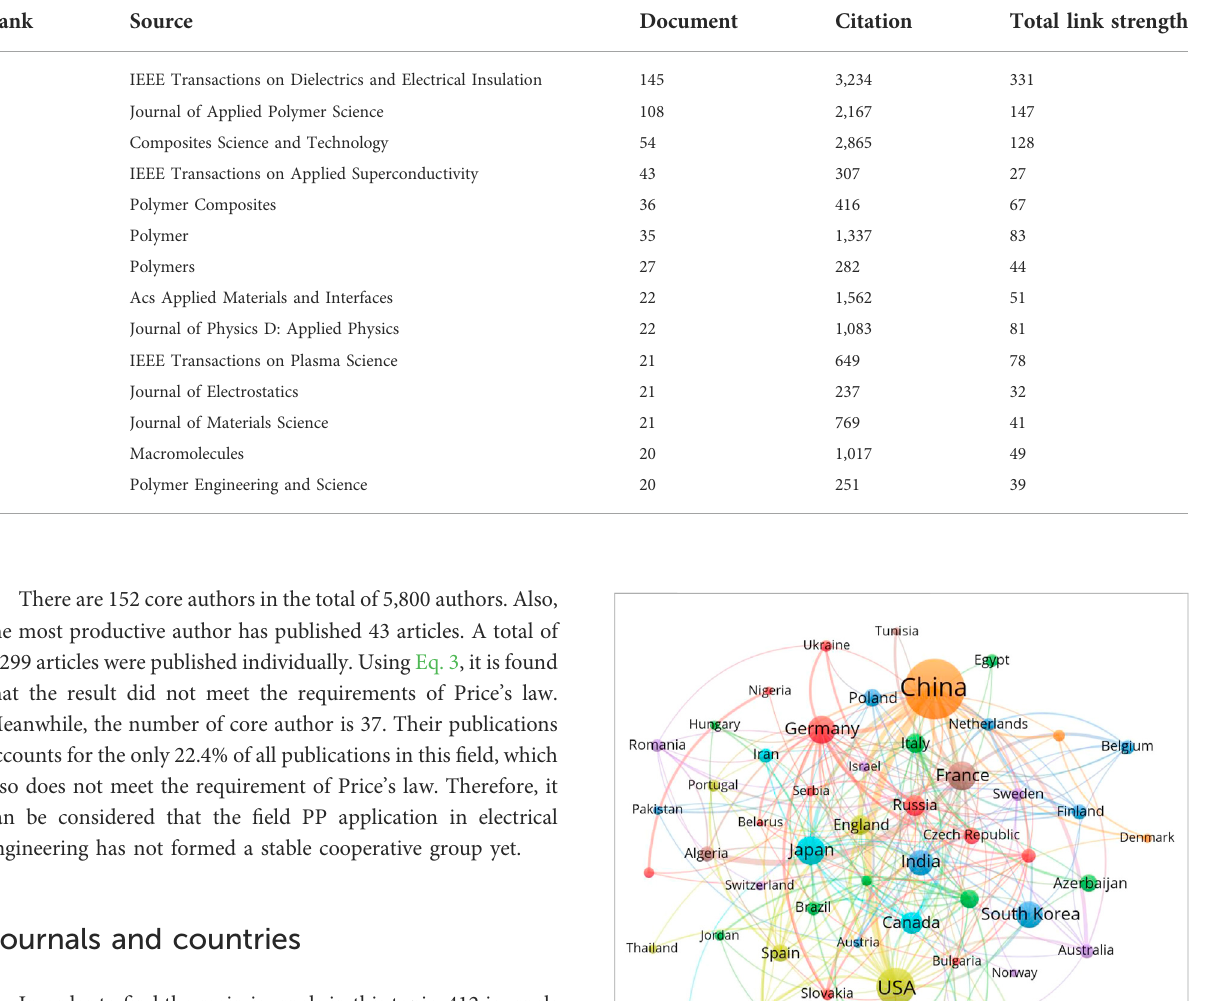
TABLE 5 Main journals in PP application in electrical engineering.